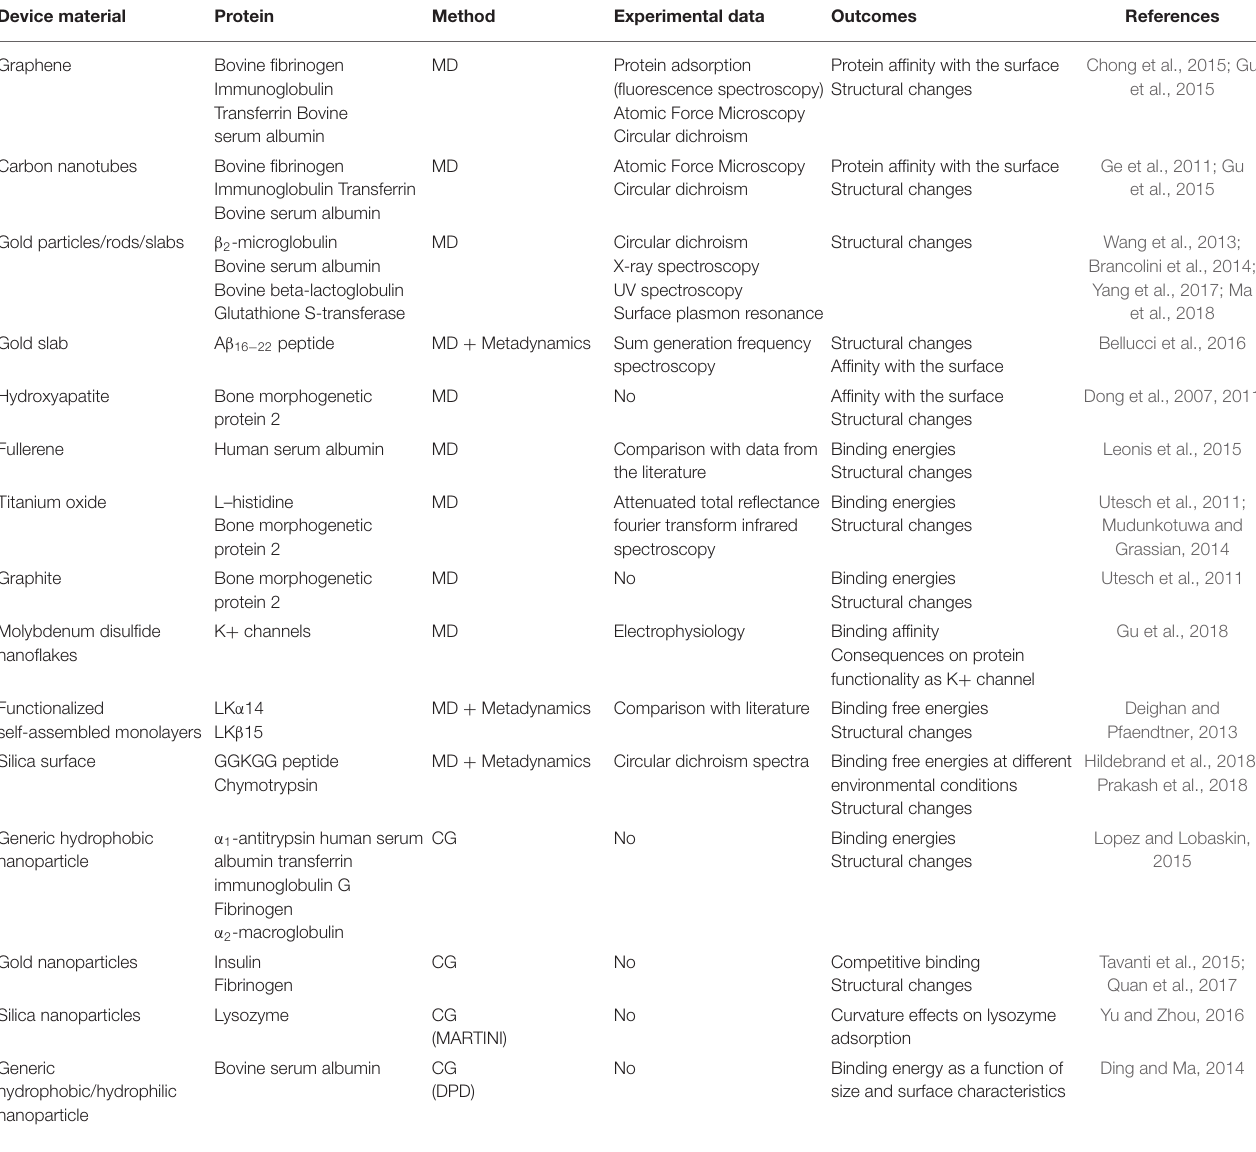
TABLE 3 | Detailed summary of computational protein corona